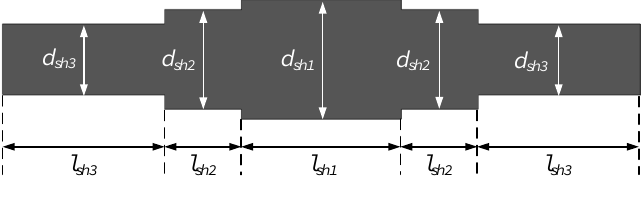
Figure 10. Structure of the shaft.